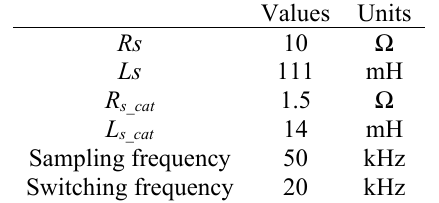
Table 3. Parameters considered in the